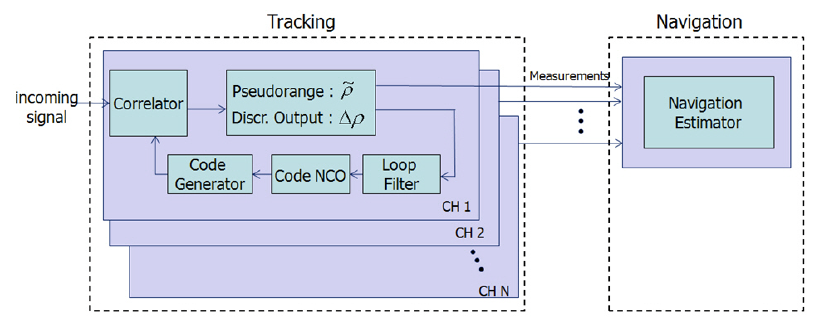
Figure 3. Receiver implementation of ITL (top) and VTL